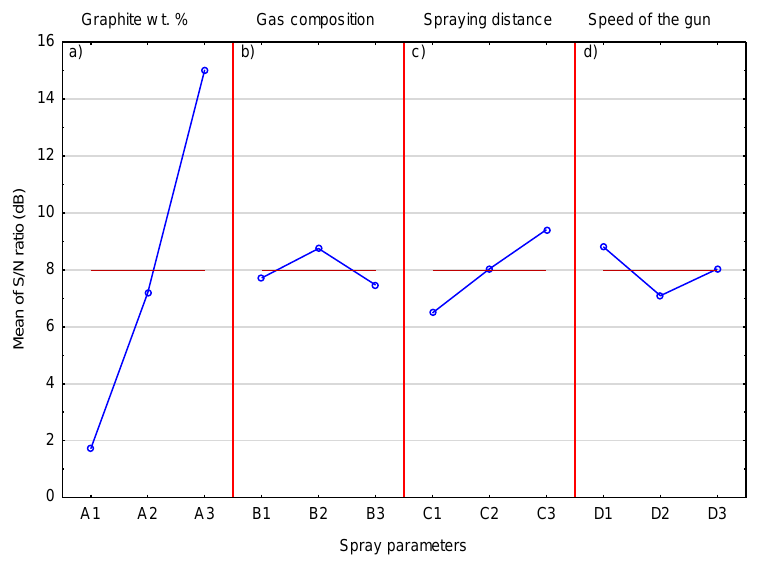
Figure 14. The mean S/N ratio for graphite. Table 9. Results of the Taguchi experiment for hardness of Cr 3 C 2 -25(Ni20Cr)/Ni-25Graphite coatings. Experiment No.